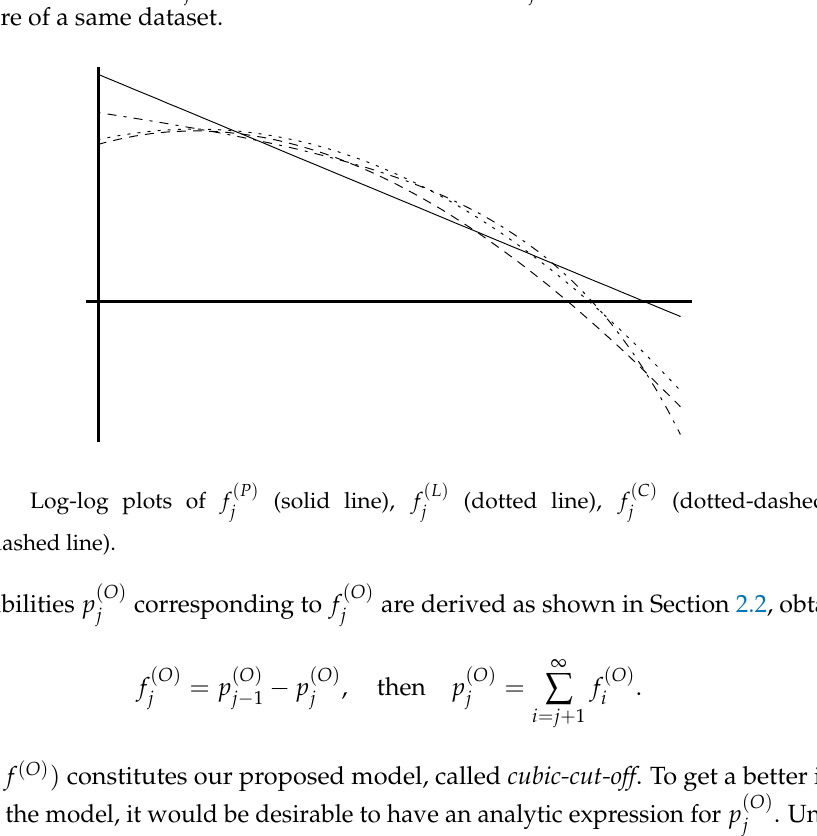
( L ) (dotted line), f j